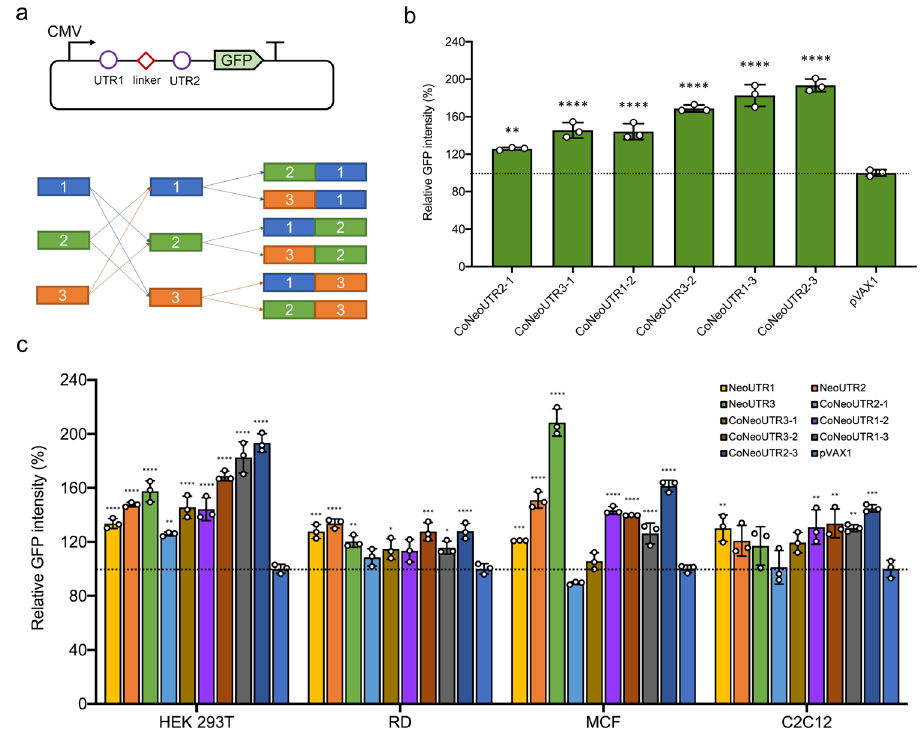
Fig. 5 Effects of combinatorial 5 ′ UTRs on GFP expression in various cell lines. a We constructed six distinct 5 ′ UTR combinations by combining different pairwise permutations of the three validated 5 ′ UTR candidates with a CAACAA linker between them, and then inserted these combinations into the pVAX1-GFP plasmid directly upstream of the Kozak sequence. b GFP expression from the 5 ′ UTR combinations on GFP expression in HEK 293T cells. Statistical differences between groups were analyzed by ordinary one-way ANOVA with 95% con fi dence interval. The relative protein expression was normalized to that from the pVAX1-GFP plasmid, set as 100 (%) and highlighted as a gray dotted line. Data are presented as mean values ± SD for three biological replicates. The p -values for CoNeoUTR2-1, CoNeoUTR3-1, CoNeoUTR1-2, CoNeoUTR3-2, CoNeoUTR1-3, and CoNeoUTR2-3 vs pVAX1 are 0.0025, <0.0001, <0.0001, <0.0001, <0.0001, and <0.0001. c Test of the single and combinatorial 5 ′ UTRs on GFP expression in various cell lines. Source data are provided as a Source data fi le. Statistical differences between groups were analyzed by two-way ANOVA with 95% con fi dence interval. Dunnett test was performed to correct for multiple comparisons in ANOVA post-hoc analysis. The relative protein expression was normalized to that from the pVAX1-GFP plasmid, set as 100 (%) and highlighted as a gray dotted line. Data are presented as mean values ± SD for three biological replicates. In HEK 293T cell lines, the p -values for NeoUTR1, NeoUTR2, NeoUTR3, CoNeoUTR2-1, CoNeoUTR3-1, CoNeoUTR1-2, CoNeoUTR3-2, CoNeoUTR1-3, and CoNeoUTR2-3 vs pVAX1 are <0.0001, <0.0001, <0.0001, 0.0002, <0.0001, <0.0001, <0.0001, <0.0001, and <0.0001. In RD cell lines, the p-values for NeoUTR1, NeoUTR2, NeoUTR3, CoNeoUTR2-1, CoNeoUTR3-1, CoNeoUTR1-2, CoNeoUTR3-2, CoNeoUTR1-3, and CoNeoUTR2-3 vs pVAX1 are